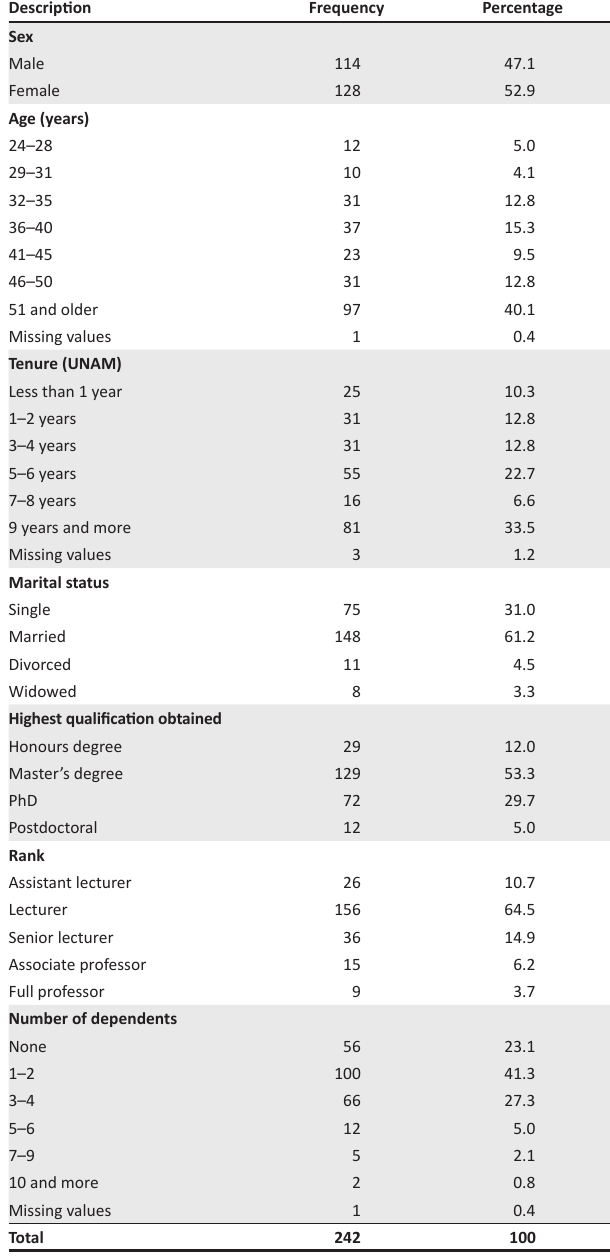
TABLE 1: Biographical details of the